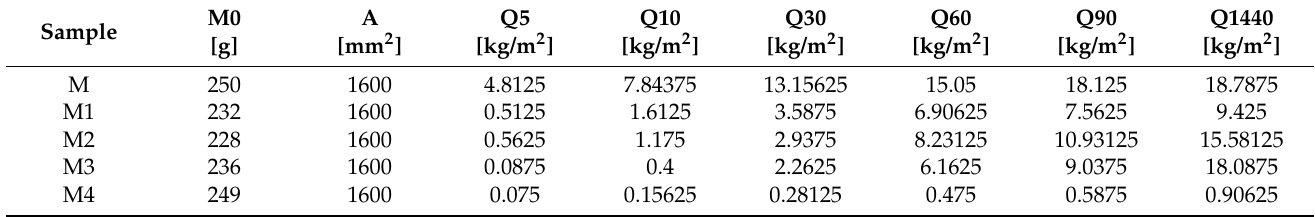
Table 3. The average value of the initial weight of the samples, the area of contact with water, and the average values of the absorption